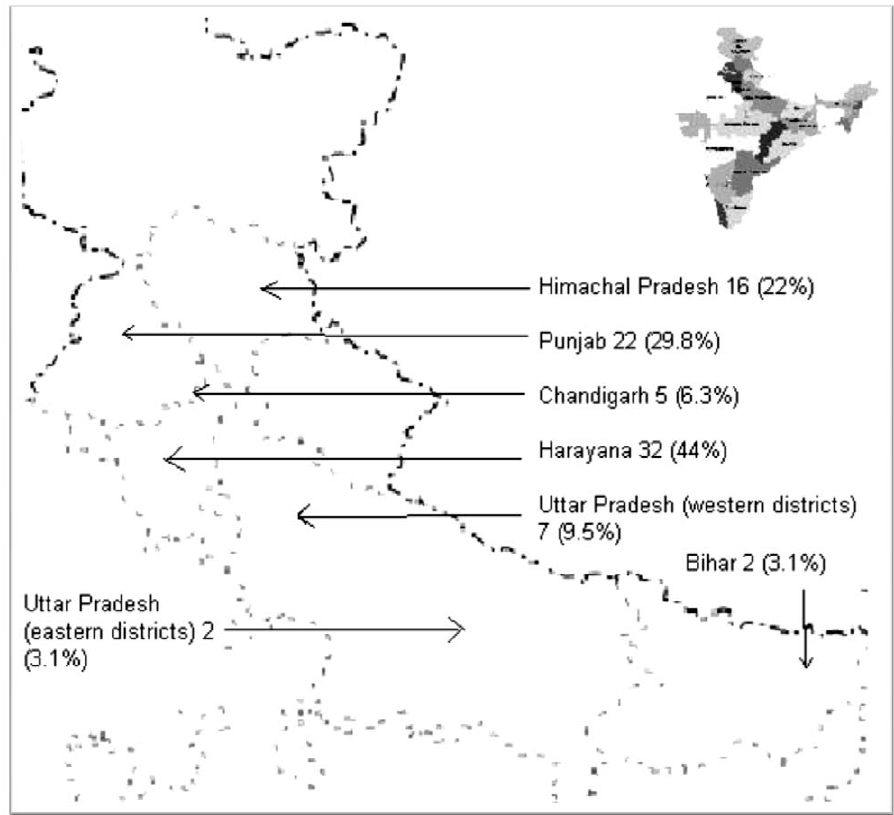
Figure 2. Area of residence of 86 patients of leptospirosis in India.